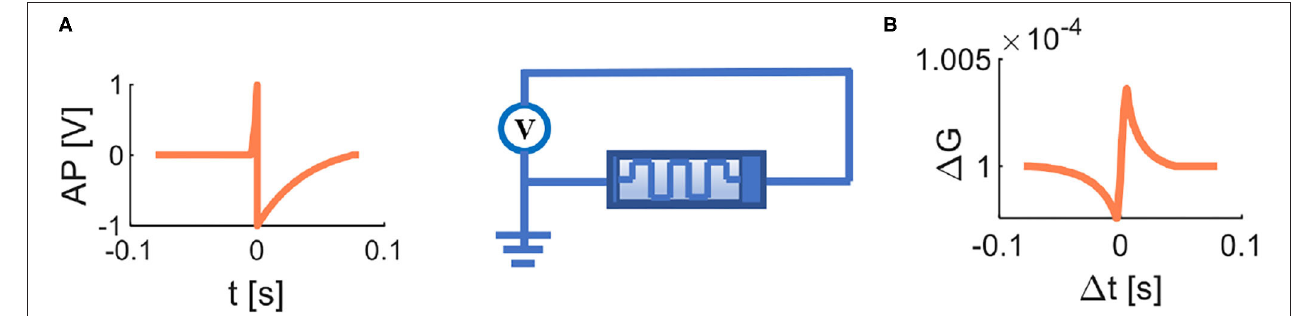
FIGURE 6 | The memristive STDP. (A) The voltage is applied to the memristor. (B) STDP learning curve of a memristor.